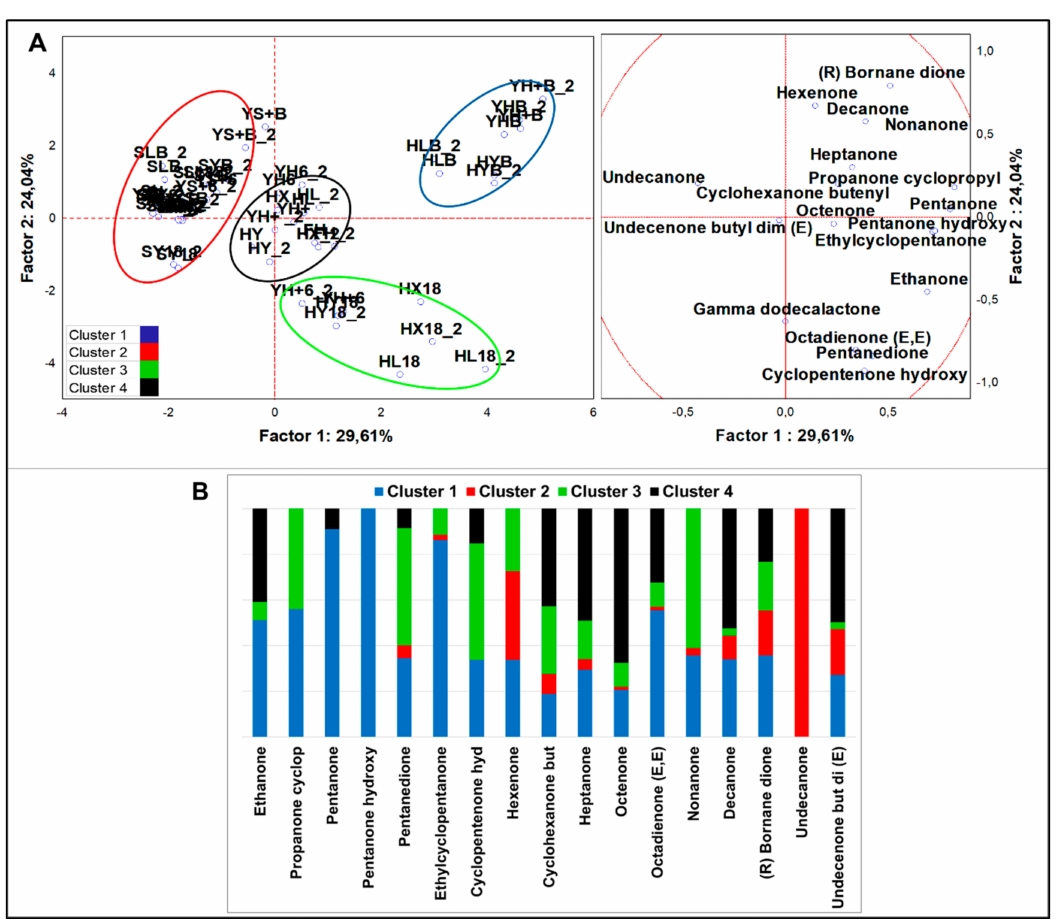
Figure 4. ( A ) PCA of cases and variables on ketones ( p < 0.05); ( B ) K-means clustering analysis (at least p <